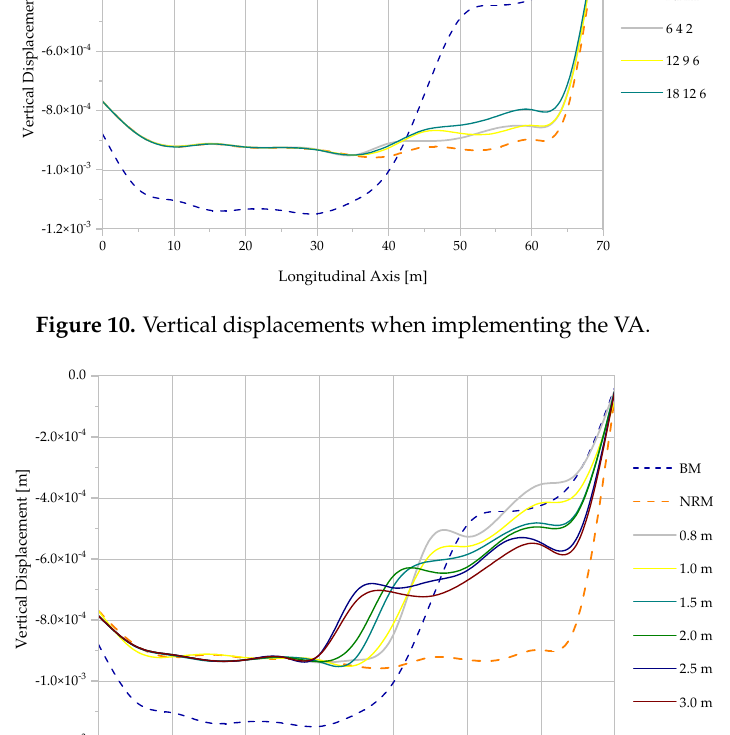
Figure 10. Vertical displacements when implementing the VA.